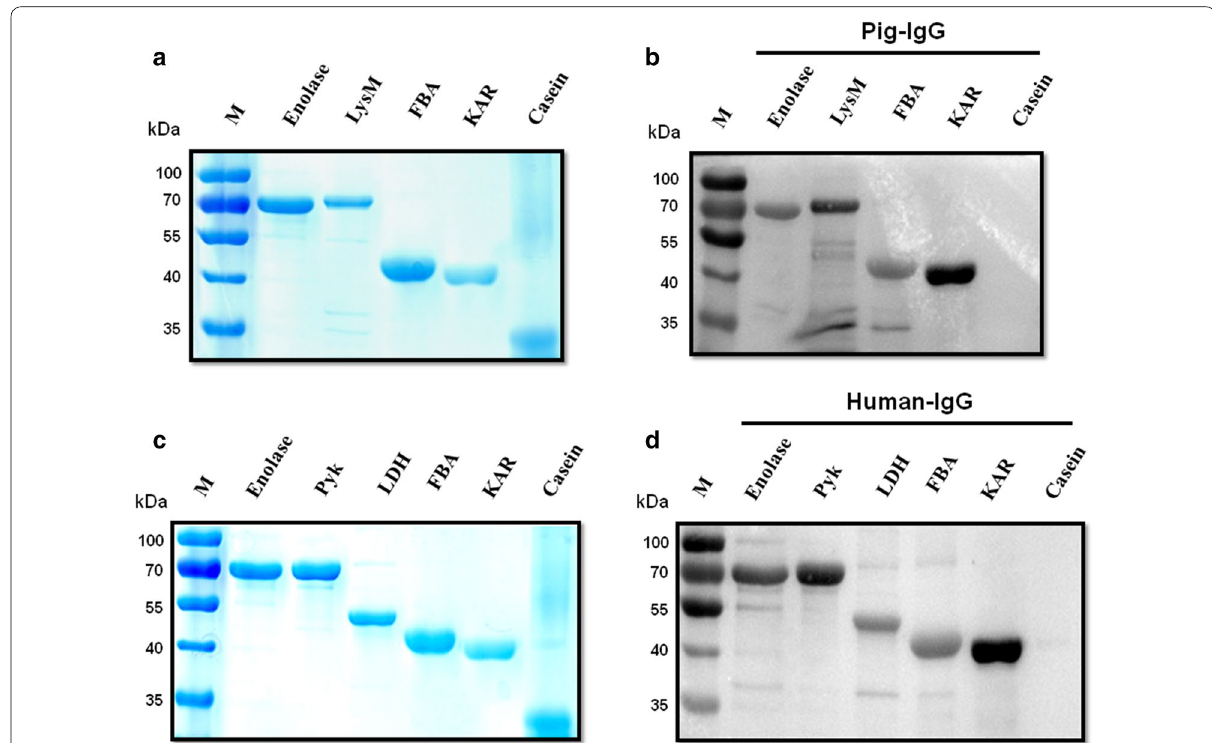
Fig. 2 Identification the binding of pIgG or hIgG to IBPs of S. suis 2 by Far-western blot. SDS-PAGE ( a , c ) and Far-western blot analysis ( b , d ) of the S. suis 2 recombinant IBPs. Recombinant proteins (Enolase, LysM, Pyk, LDH, FBA, KAR) and casein were subjected to SDS-PAGE, then transferred onto PVDF membranes and incubated with pIgG or hIgG. Bound pIgG or hIgG was recognized with HRP conjugated SPA. Casein was used as a negative control for non-specific binding to